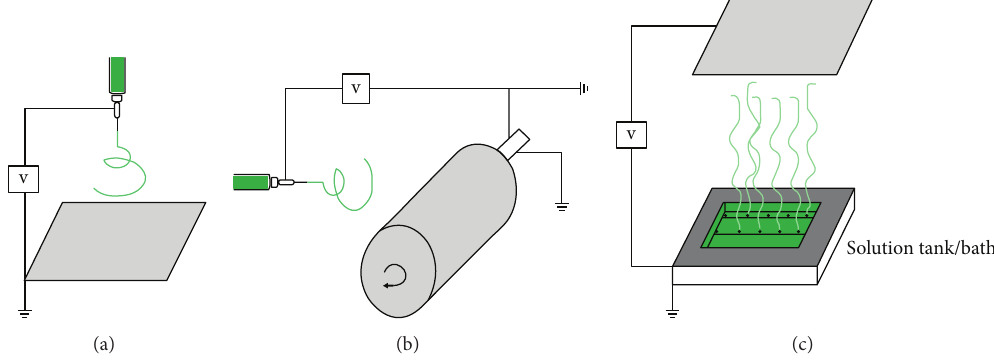
Figure 5: Common configuration of electrospinning: (a) vertical; (b) horizontal; (c)